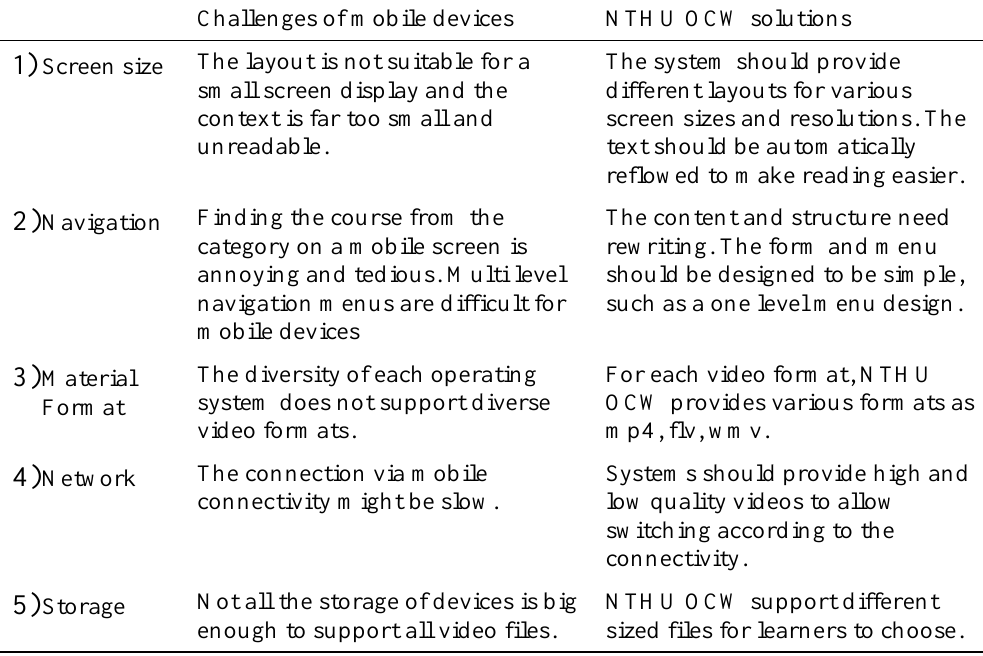
Challenges and Solutions of Learning the OCW via Mobile Devices Challenges of mobile